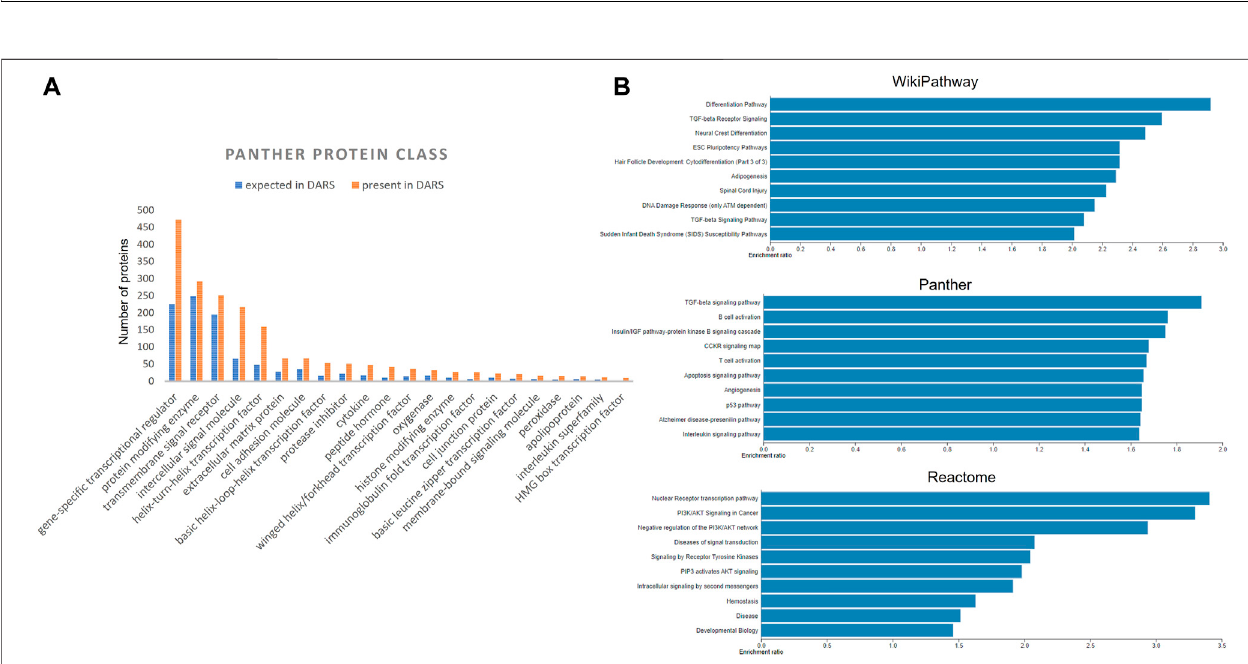
Frontiers in Toxicology |